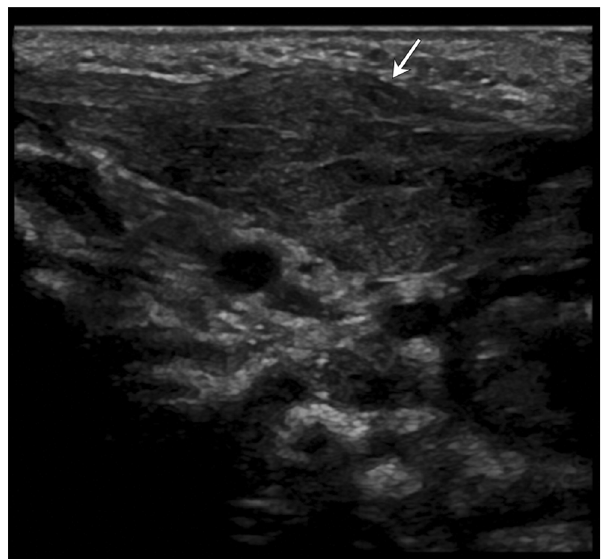
Fig. 19 Fibromatosis colli Neck ultrasound obtained in a 6-week-old revealed fusiform enlargement of the left sternocleidomastoid without discernible underlying masses. Patient was diagnosed with fibromatosis colli. This patient had a history of dytocic birth